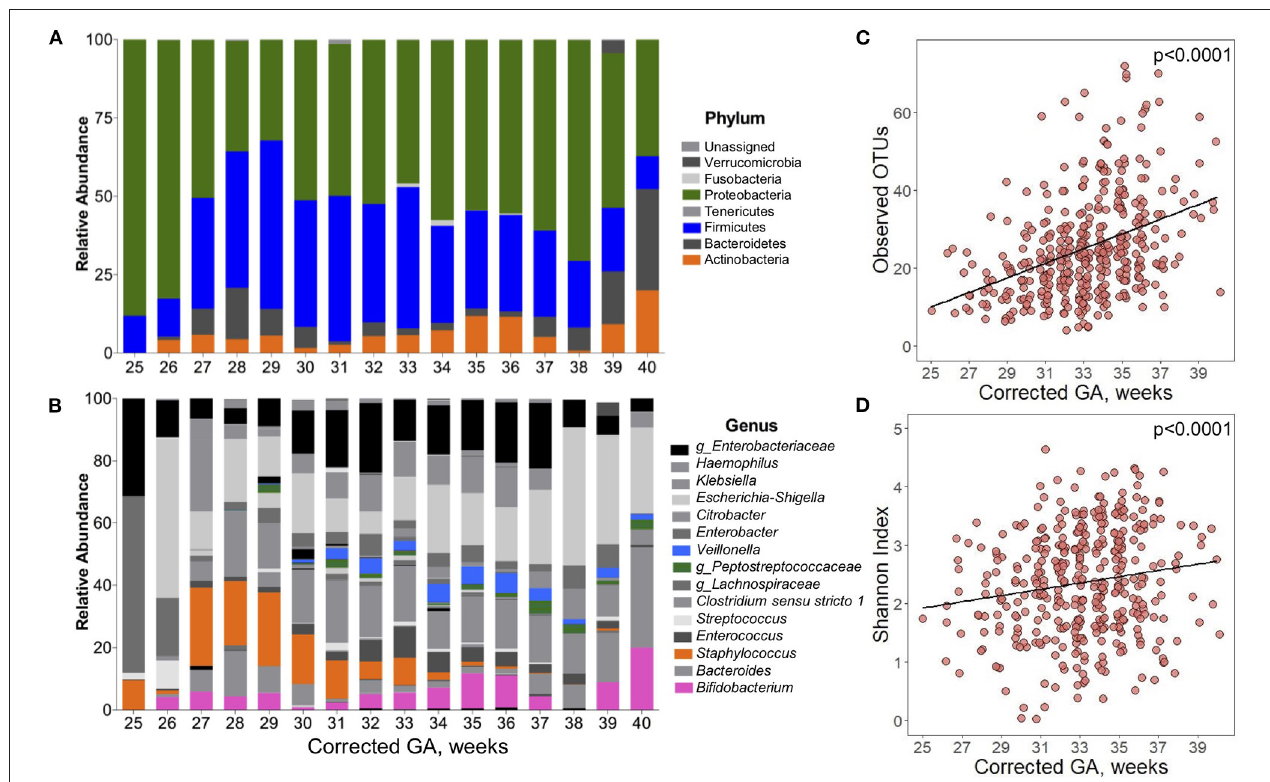
FIGURE 2 | Postpartum development of the gut microbiota composition of preterm infants. Over time, there were significant changes in the composition of the gut microbiota of preterm infants. Taxonomical composition at (A) phylum and (B) genus level. Highlighted in color are the bacteria that significantly changed over time ( q < 0.05). Differences calculated using Microbiome Multivariable Association Linear Models (MaASLin2) with infants as a random effect term. (C) Observed OTUs and (D) Shannon diversity Index significantly increased over time. Differences calculated using linear mixed-effect model with infants as a random effect term. Adjusted for antibiotic use. Corrected GA: gestational age at birth + postnatal age. GA, gestational age.